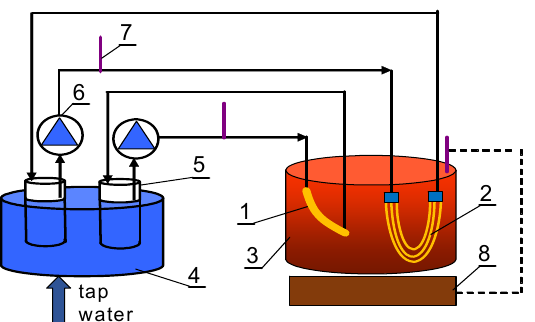
Figure 3. Schematic diagram of the MD installation with submerged modules. 1—submerged SMD-V8 module, 2—submerged SMD-S6 module, 3—feed tank, 4—cooling bath, 5—distillate tank, 6—peristaltic pump, 7—thermometer, 8—magnetic mixer with heating element.